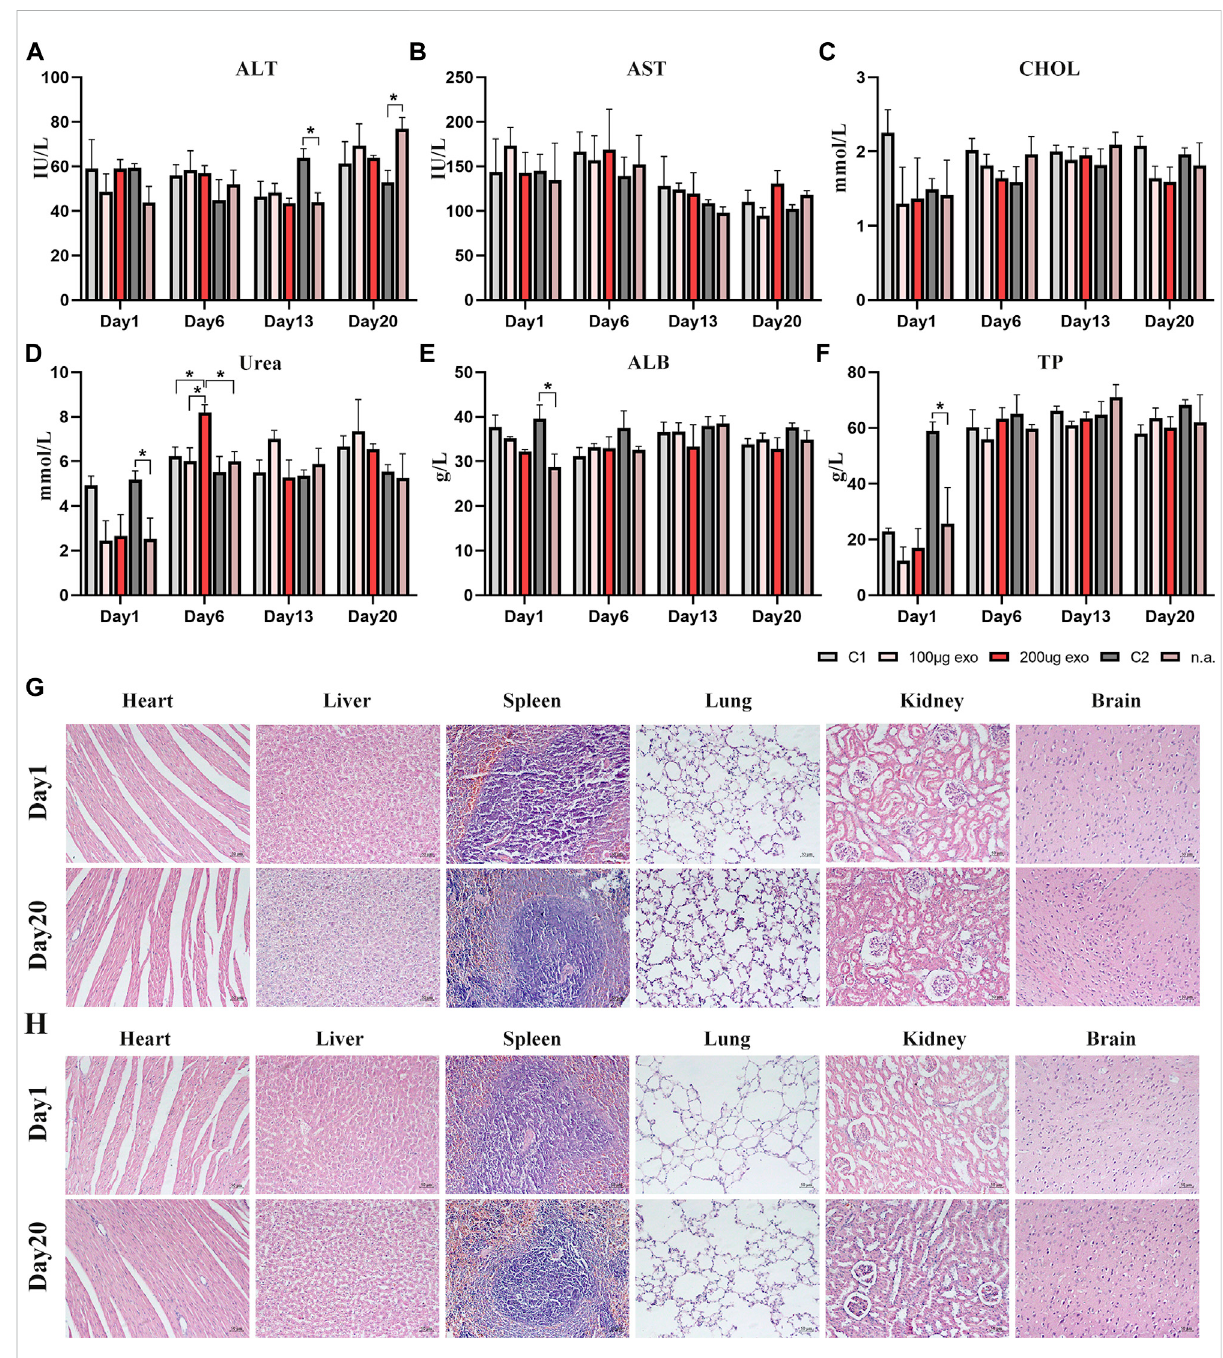
Bloodbiochemicalindexesandpathological changesinratorgans. (A) Alanineaminotransferase(* p < 0.05). (B) Aspartateaminotransferase. (C) Total cholesterol. (D) Urea (* p < 0.05). (E) Albumin (* p < 0.05). (F) Total protein (* p < 0.05). N = 4 pergroup. Data are expressedthe mean± SEM. (C1, Control 1; C2, Control 2). Reference ranges: ALT, 38.84 – 85.56 IU/L; AST, 75.79 – 237.34 IU/L; CHOL, 1.05 – 2.61 mmol/L; Urea, 2.15 – 8.31 mmol/L; ALB, 30.89 – 45.08 g/L; TP, 52.41 – 85.53 g/L. (G) HE-stained pathological sections of major organs in the Control 1 group on days 1 and 20.